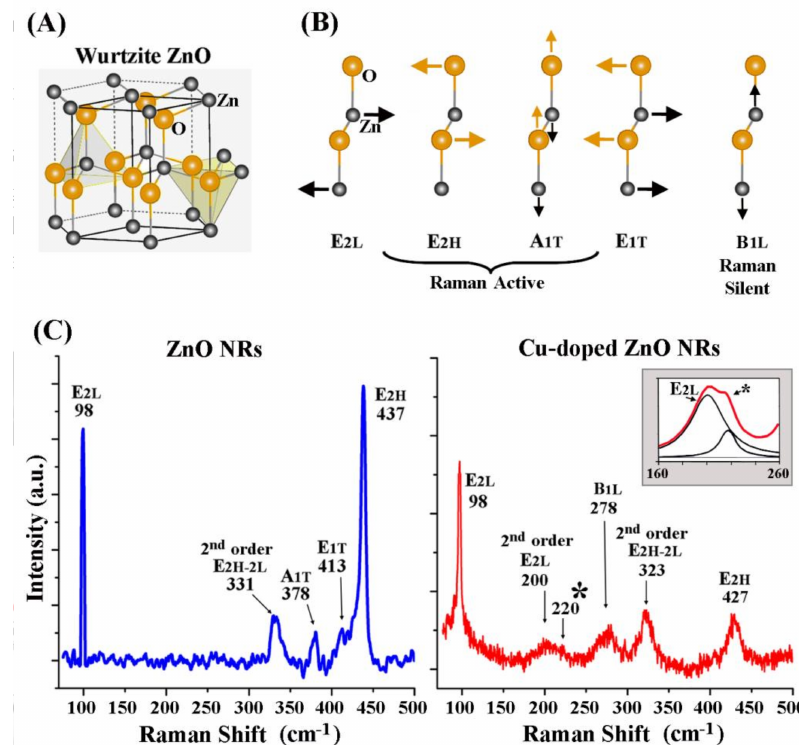
Figure 4. Raman spectra of undoped and Cu-doped ZnO NRs, as synthesized on Si substrates using Au NP and Cu 3 Si NB catalysts, respectively. ( A ) A ball-and-stick model of atomic arrangements of Zn and O is displayed for an undoped, wurtzite ZnO crystal; ( B ) Characteristic Raman vibration modes of wurtzite ZnO are schematically depicted; ( C ) The differences in the Raman scattering behaviors between the undoped (blue) and Cu-doped (red) ZnO NR samples are clearly resolved. The Raman spectra are ensemble-averaged signals acquired from a collection of undoped ZnO NRs (blue) and concentrated modules of Cu-doped ZnO NRs on NBs (red). The inset in the Cu-doped ZnO spectrum is the magnified view of the curve fit (red) and the peak fits (black) of the scattering data between 160 and 260 cm − 1 . The Cu(I)–O peak is marked with an